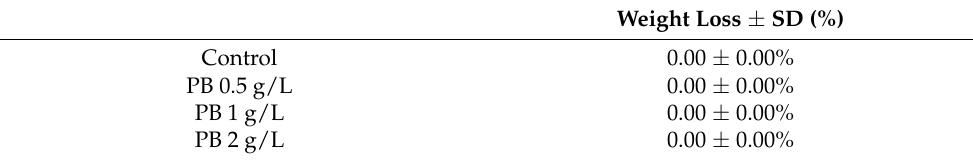
Table 2. Air permeability values of the control polyester before coating and the samples functionalised with Prussian blue (PB) formulations at different concentrations (0.5 g/L, 1 g/L and 2 g/L) converted into different units. Table 3. Weight loss percentage of polyester knits coated with Prussian blue (PB) at different concentrations (0.5 g/L, 1 g/L and 2 g/L) after 3000 cycles in the Martindale machine, (n = 3, ±